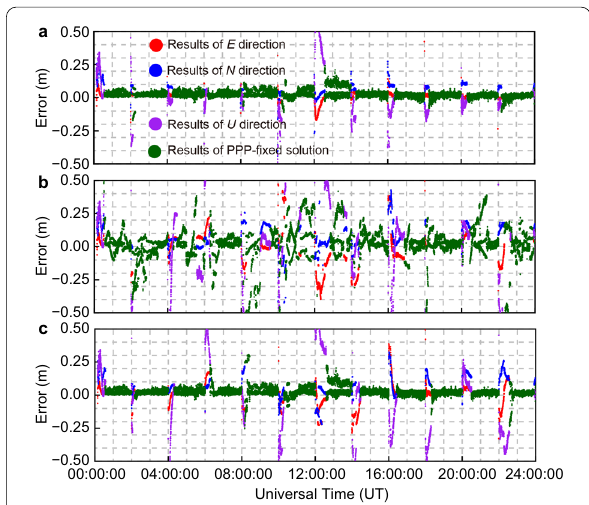
Fig. 11 The convergence time of PPP–RTK constrained by ionospheric delay corrections with a no TID, and with a TID of an amplitude of 1 TECU and the variance of b 0.088 m, and c 0.38 m